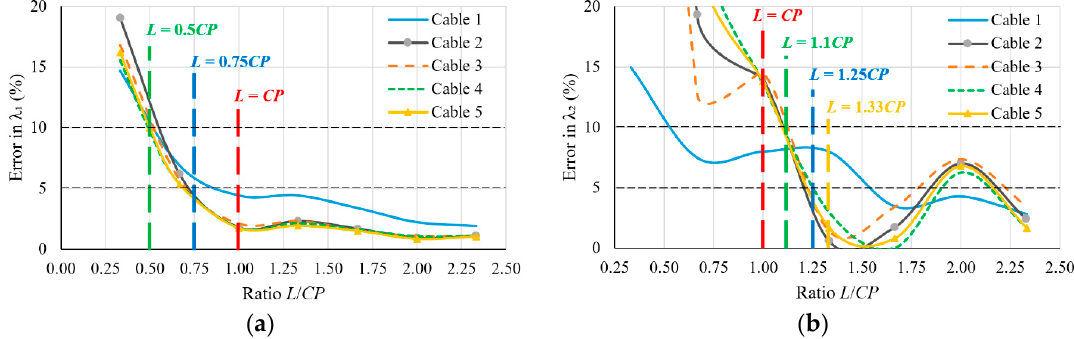
Figure 4. Error as a function of the ratio L / CP in: ( a ) λ 1 ; ( b ) λ 2 .